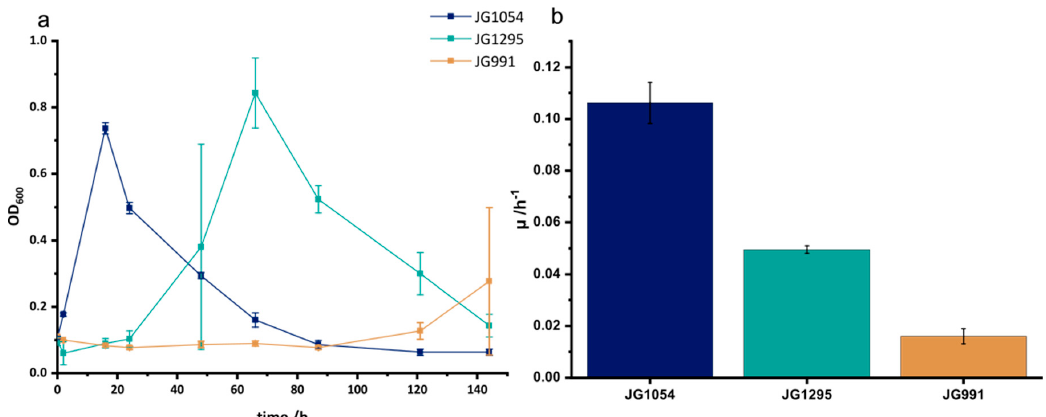
Figure 3. Anaerobic growth in MOPS buffered medium supplemented with 40 mmol/L DMSO, 20 mmol/L glucose, and 0.1% yeast extract. ( a ) Growth curve for the previous production strain (JG991) and the newly adapted strain (JG1295) in comparison to a reference strain without modifications in the mixed acid fermentation pathway (JG1054). The growth rates for this experiment are represented in ( b ).